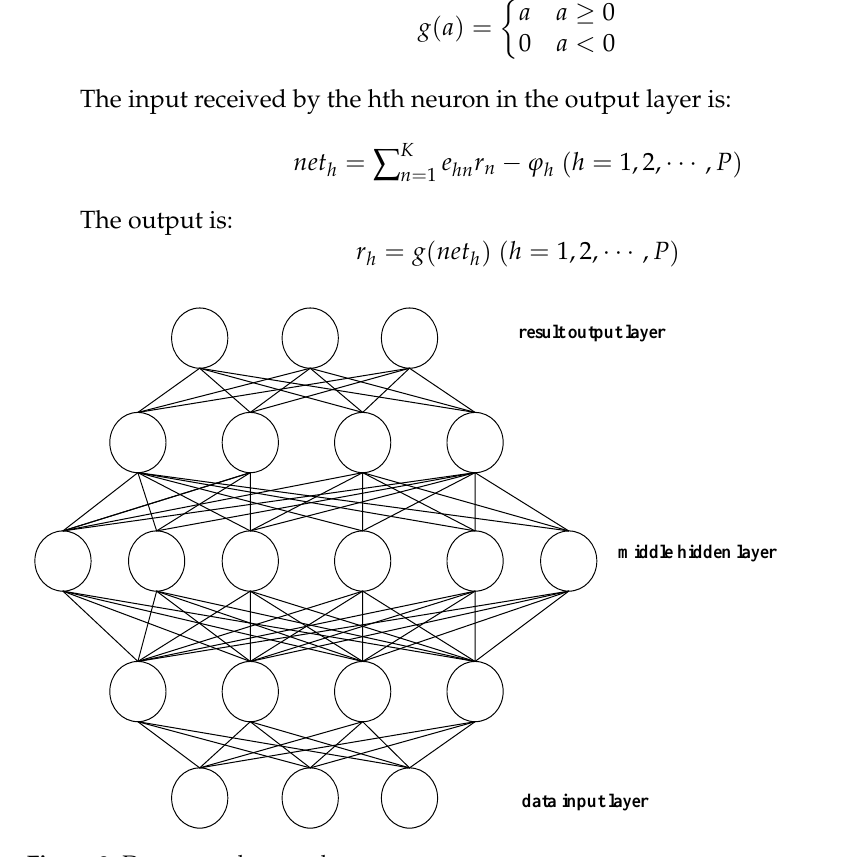
Figure 3. Deep neural network structure.